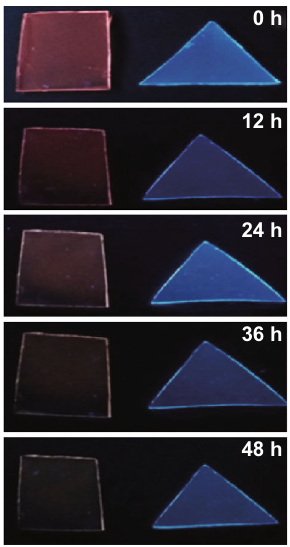
Fig. 8 Photographs of a CdTe film and a CD epoxy resin film under UV illumination taken at different time intervals [88]. Copyright (cid:2) 2016 The Authors. Published by Elsevier